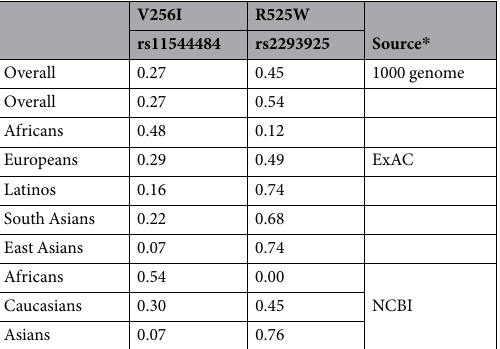
Table 1. Minor Allele Frequency (MAF) variants for TOP1MT . * Source: 1000 genomes: